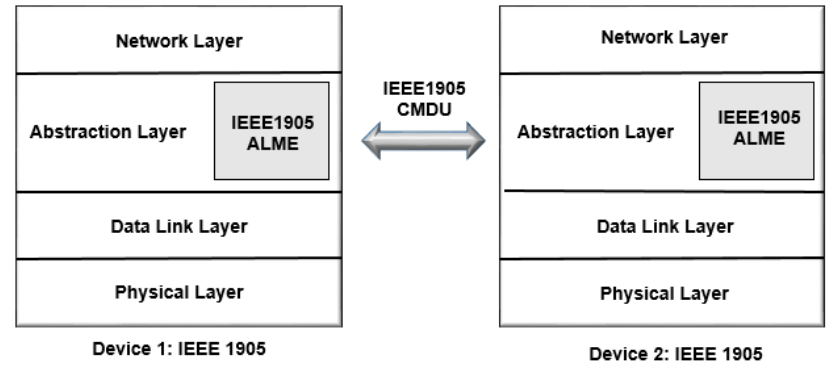
Figure 10. Illustration of the protocol structure for IEEE 1905.